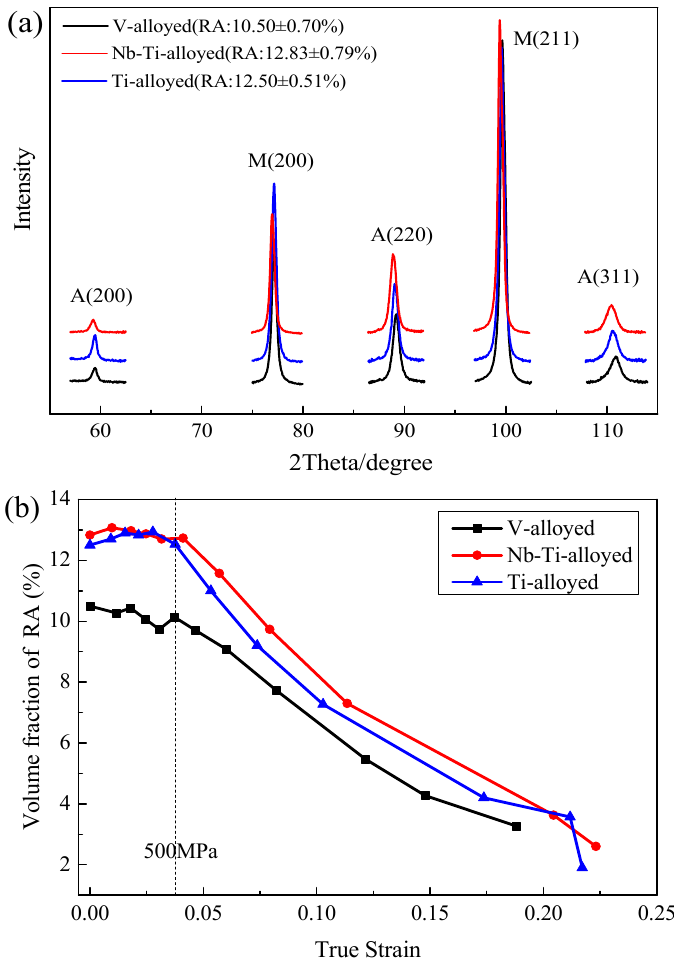
Figure 4. XRD diffraction patterns and corresponding volume fraction of RA in the investigated steel ( a ), and the volume fraction of RA at different strains ( b ).